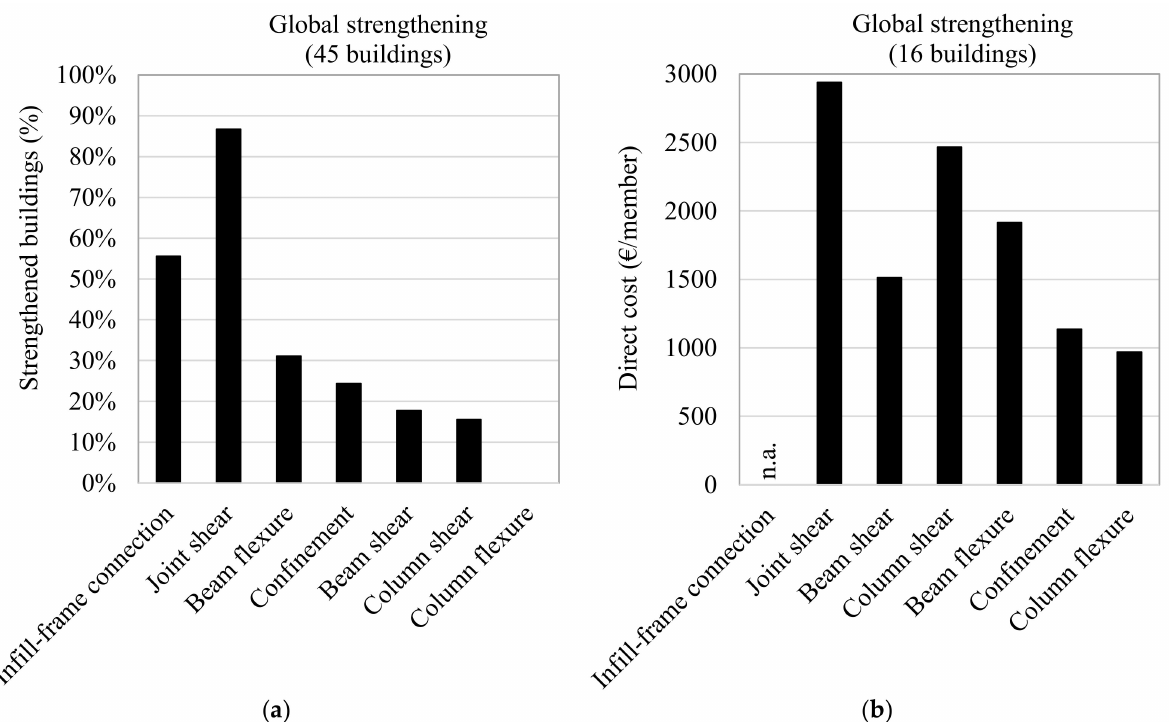
Figure 7. FRP-strengthening interventions adopted in accordance with a global strengthening strategy ( a , b